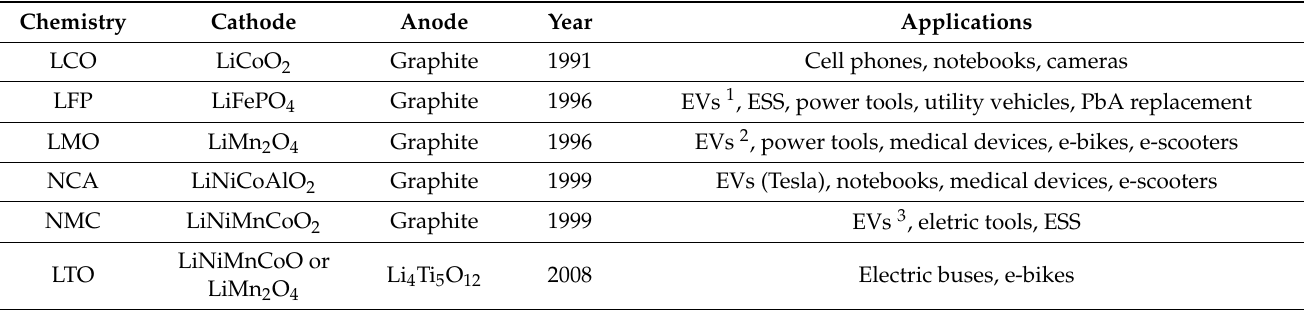
Table 1. Most common lithium-ion chemistries and their applications. Adapted from